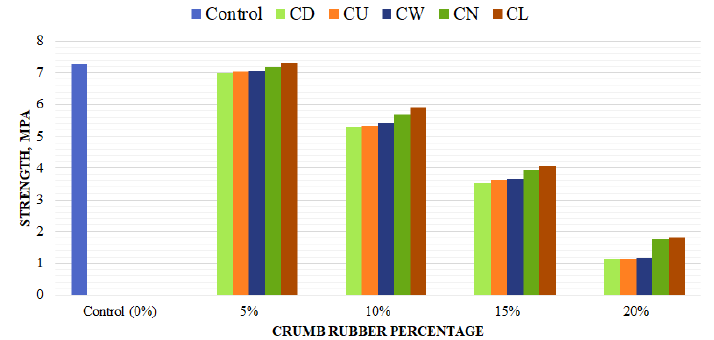
Figure 12. Indirect tensile strength at 28 days.